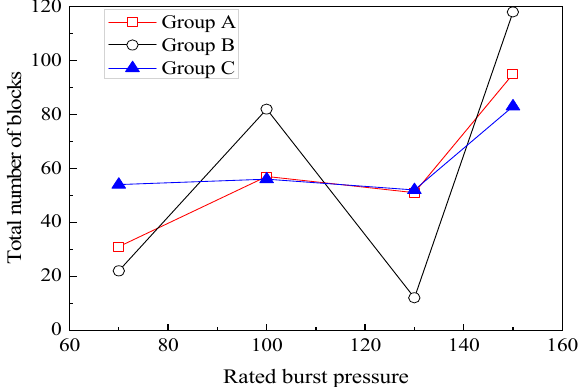
Figure 10. Variation in the total block count at different blast pressure ratings.